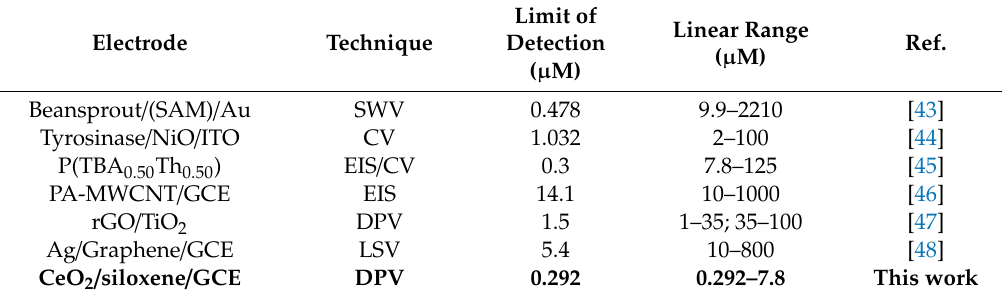
Table 1. Comparison of the analytical properties of other reported dopamine (DA) electrochemical